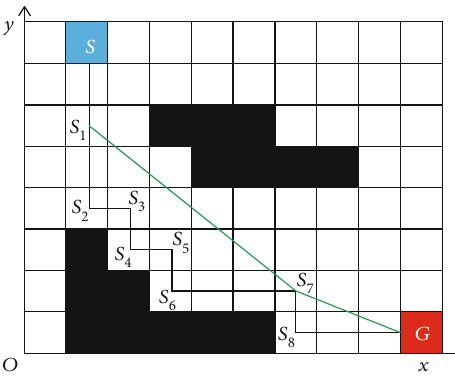
Figure 4: Floyd algorithm smoothing path